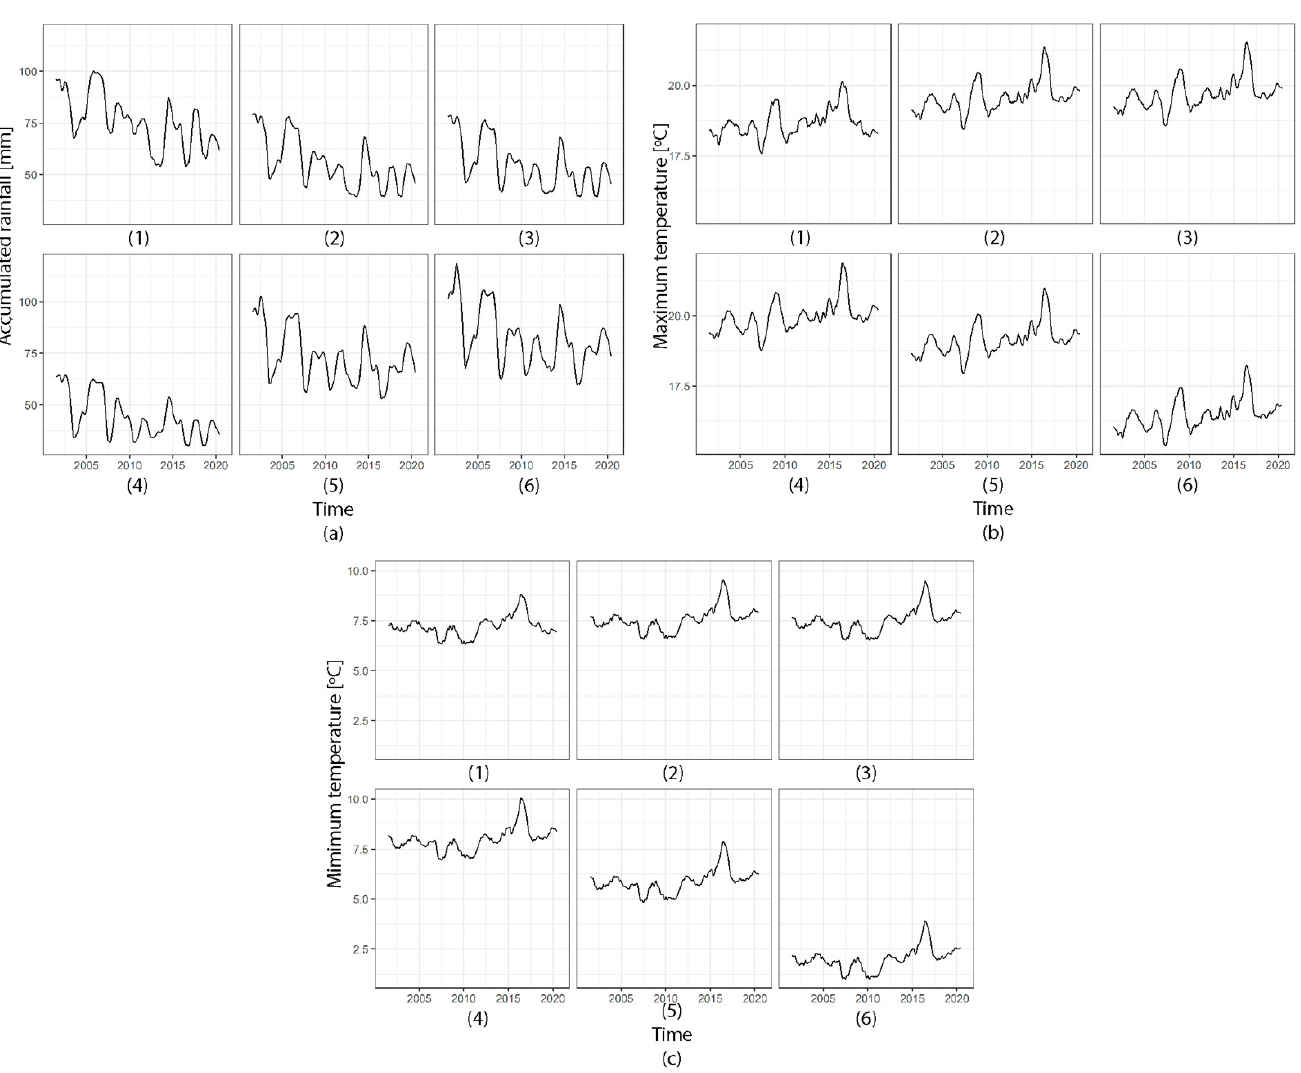
Figure 3. Trends of: ( a ) accumulated rainfall, ( b ) maximum and ( c ) minimum temperature in Biobio from 2001 to 2020 for the agro-climatics areas: ( 1 ) Secano Costero, ( 2 ) Secano interior, ( 3 ) Depresión Intermedia, ( 4 ) Cordón Isla, ( 5 ) Precordillera and, ( 6 ) Cordillera.